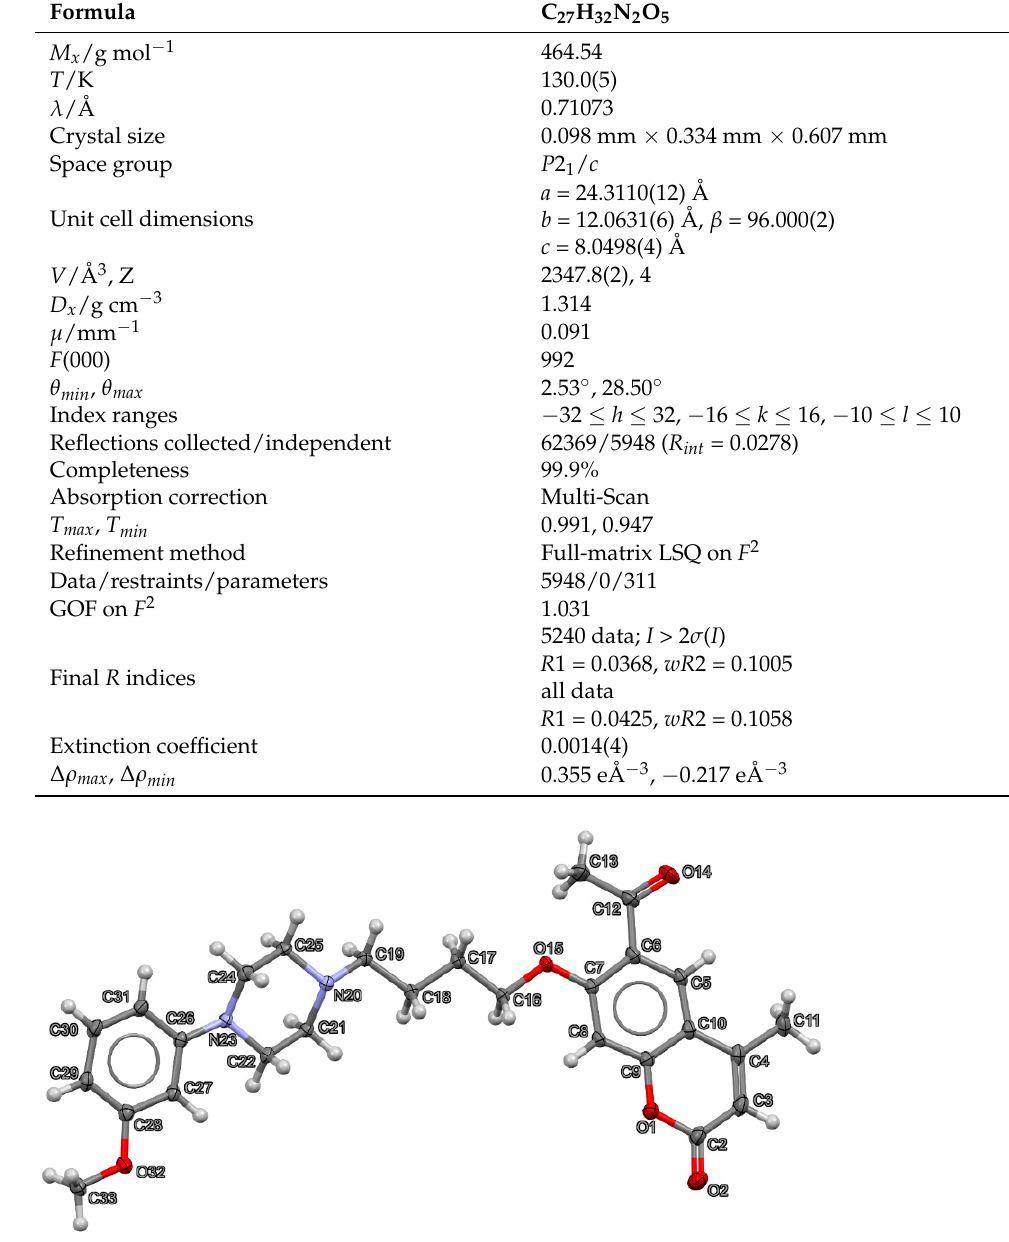
Figure 2. Thermal ellipsoid plot at 50% probability level together with numbering scheme of all non-H atoms in the structure of 6-acetyl-7-{4-[4-(3-methoxyphenyl)piperazin-1-yl]butoxy}-4-methylchromen-2-one ( 2 ). Oxygen atoms are shown in red, nitrogen in blue, carbon in dark grey and hydrogen in light grey.